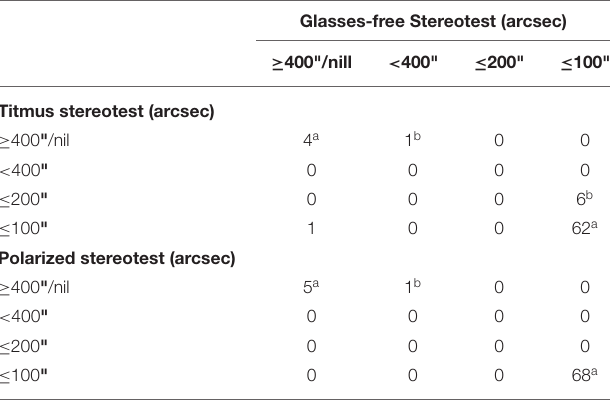
TABLE 2 | Comparison of stereopsis level between groups.